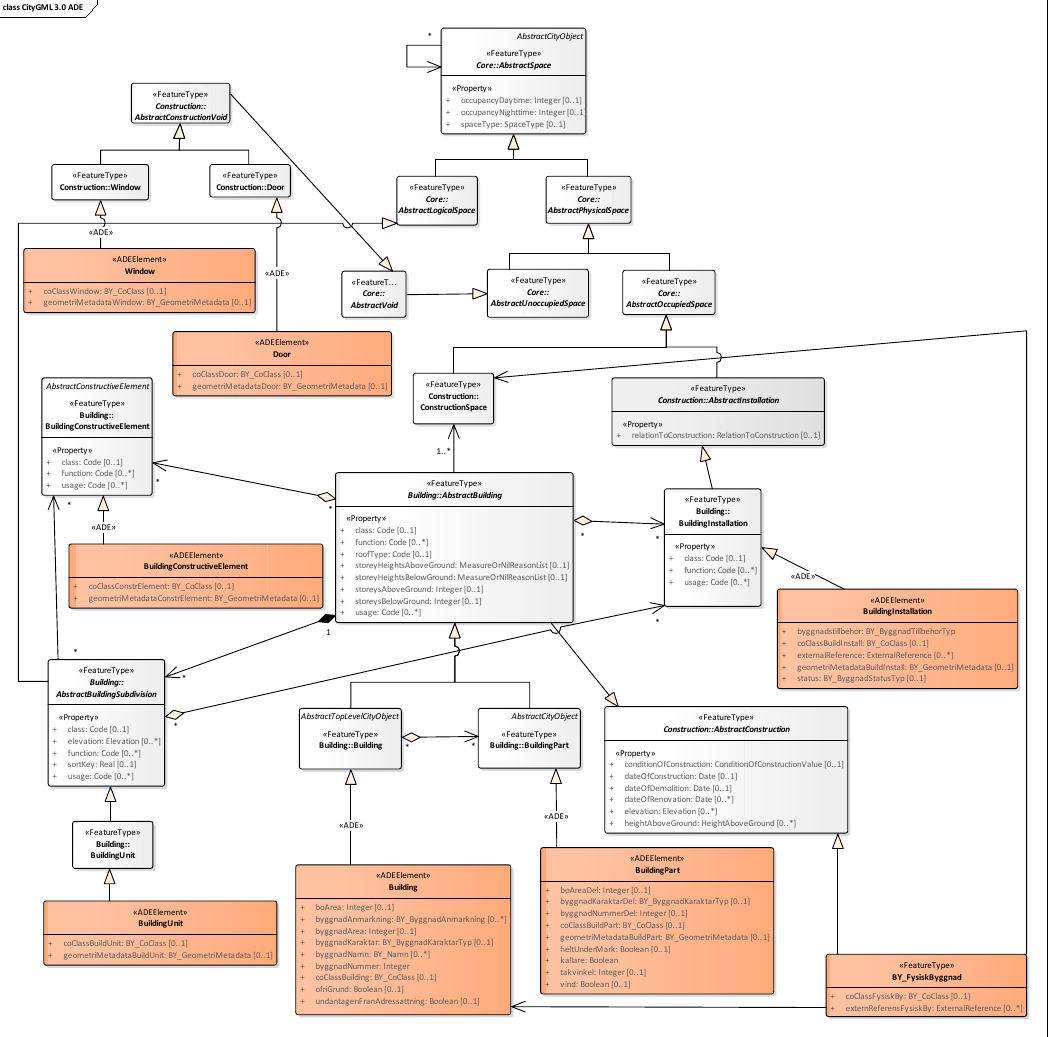
Figure 6. Selected parts of CityGML 3.0 and created Application Domain Extension (ADE) objects (in red).